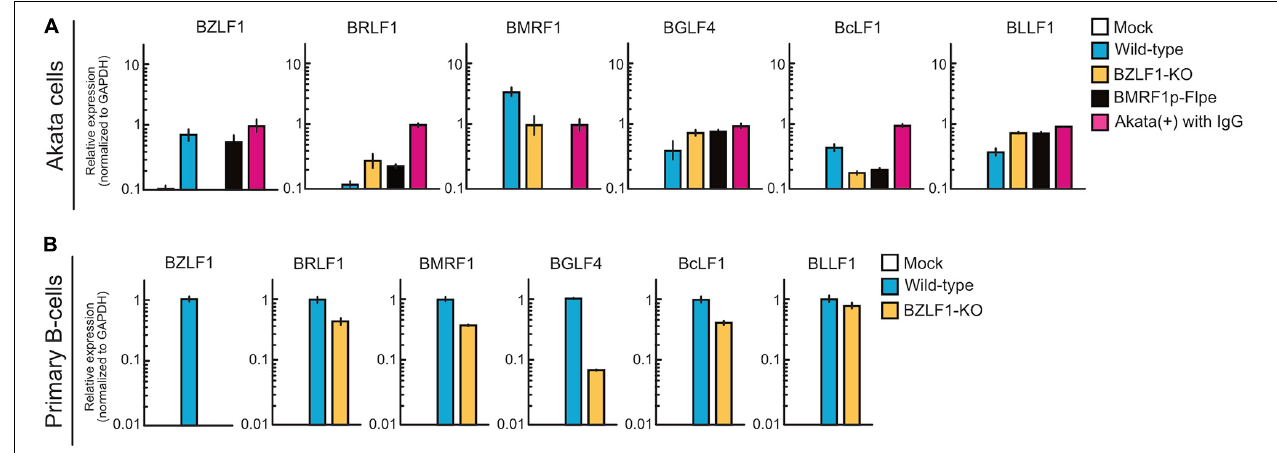
FIGURE 7 | Abortive lytic gene expression of BZLF1-KO recombinant EBV in the pre-latent phase. (A) Akata(–) cells were infected with wild-type, BZLF1-KO, or BMRF1-KO (BMRF1p-Flpe) EBV. After 2 days, total RNA was extracted and analyzed by qRT-PCR. Results are presented as means ± SD of three independent experiments and are shown relative to gene expression in the lytic-induced Akata(+) cells after treatment with IgG. (B) Purified primary B-cells were infected with wild type or BZLF1-KO EBV and harvested at 3 dpi. EBV gene expression was assessed by qRT-PCR and normalized to GAPDH expression. Results are presented as means ± SD of three independent